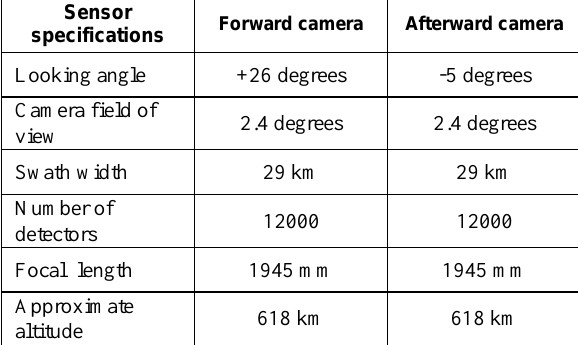
Table 1. Geometric specification of CARTOSAT-1 stereo images